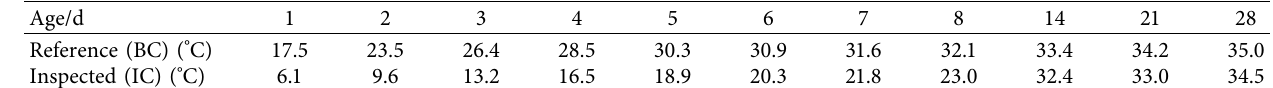
Table 2: Test results of adiabatic temperature rise of concrete.